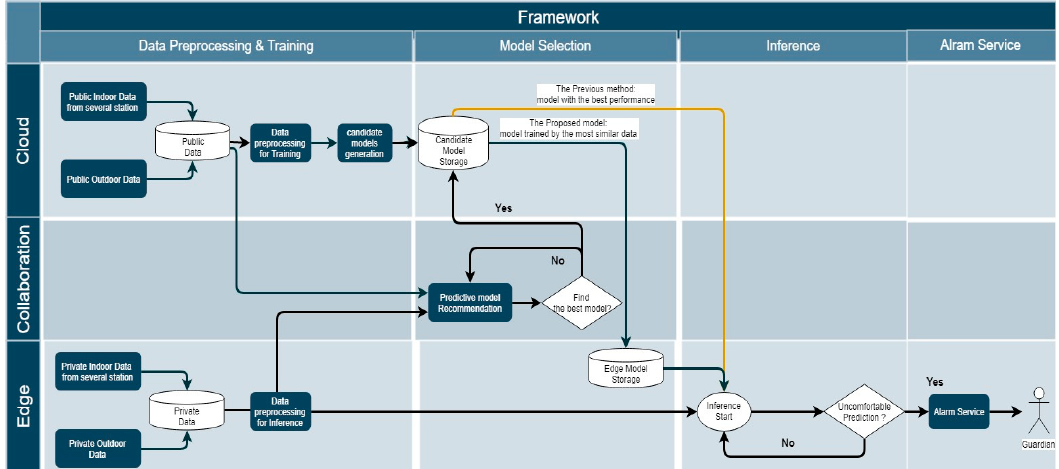
Figure 4. The dataflow of the use case.